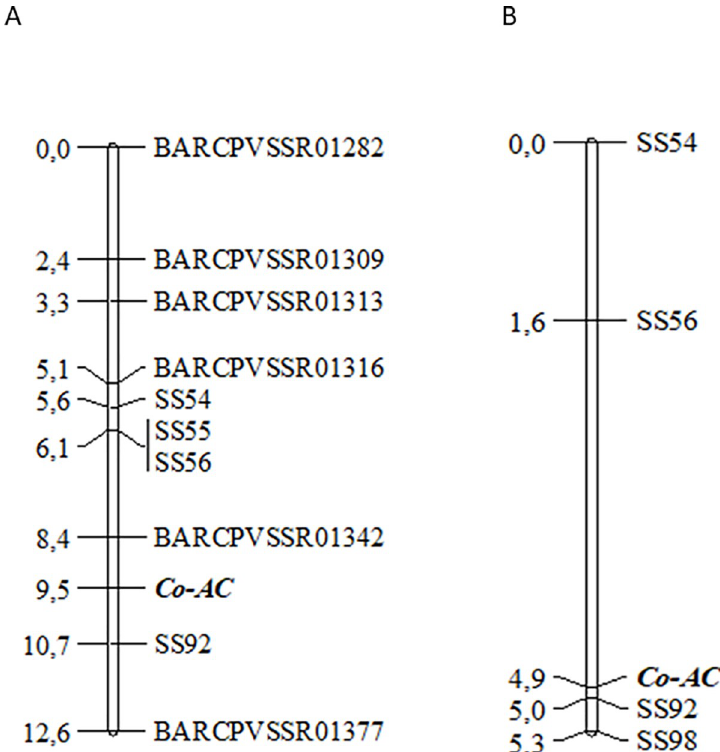
Fig 1. Genetic linkage maps of the anthracnose re´sistance locus Co-AC locus on chromosome Pv01 of Phaseolus vulgaris obtained using two different F 2 mapping populations. Fig 1A: acquired using 109 F 2 plants from Amendoim Cavalo × PI 207262 cross. Fig 1B: obtained using 187 F 2 plants from Amendoim Cavalo × G2333 cross. Linkage maps were constructed using simple sequence repeats (SSRs) and SNP KASP markers. The Co-AC locus was flanked by SNP KASP markers ss56 and ss92 in both F 2 mapping